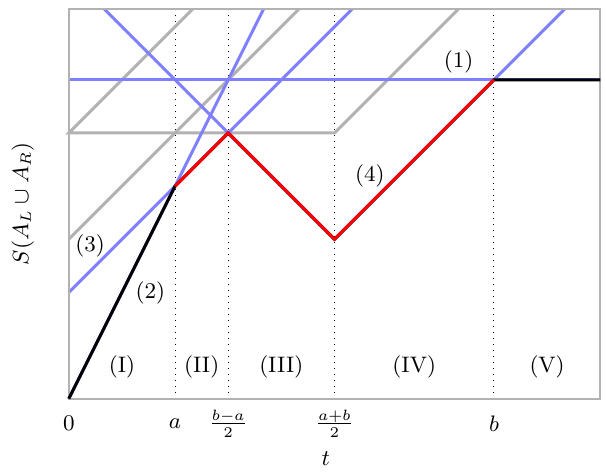
Figure 1 . BCFT channels for the von Neumann entropy at high temperature, of which the four in blue (labelled numbers as in figure 7) actually compete for the configuration with A L = A R = [ a, b ] and 3 a < b ( a = 3 , b = 12 and β = 0 . 1 shown). The channels in grey are always subdominant. The red portion of the curve, channels (3) and (4), corresponds to the island saddle of the black hole in JT gravity. Temporal regimes (I)–(V) are used in the analysis. The exact result for the free fermion theory lies on top of the black and red